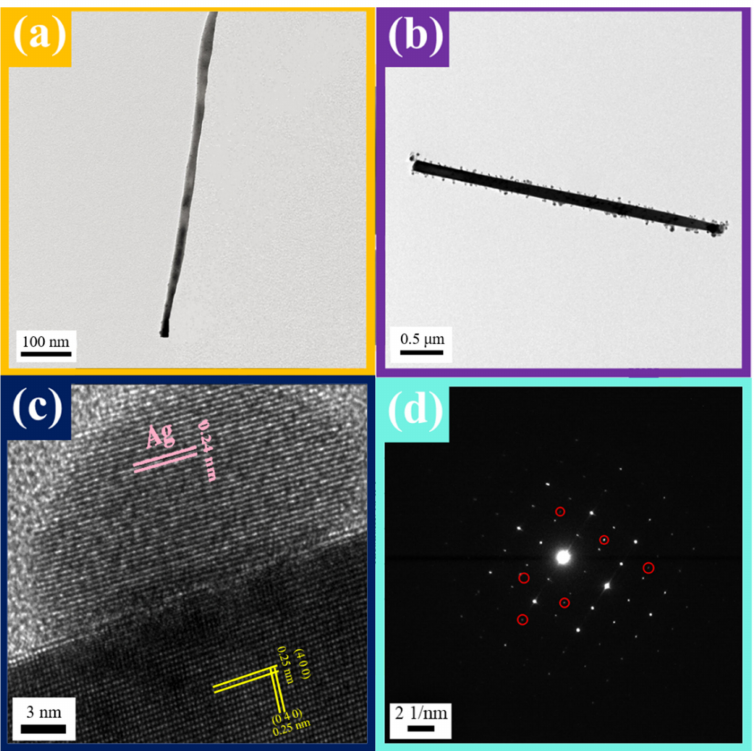
Figure 4. The low-magnification TEM images of ( a ) a 1 at% Ag-ITO NW ( b ) a 3 at% Ag-ITO NW ( c ) HR-TEM image of the Ag-ITO NW showing the lattice of Ag nanoparticle; ( d ) SAED pattern of the Ag-ITO NW showing the new diffraction spots in the ITO NW.